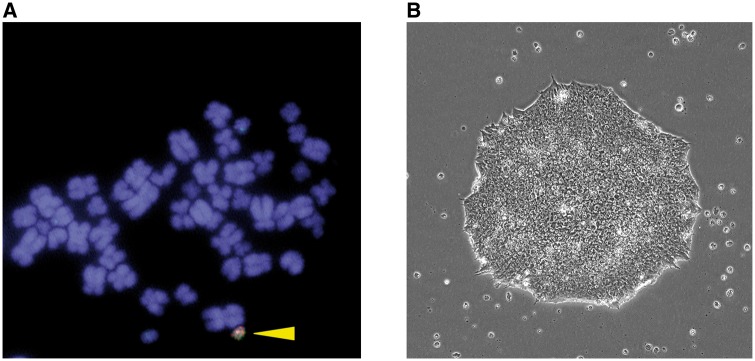
 Human iPSCs after microcell-mediated chromosome transfer of human artificial chromosome. (A) FISH analysis. The HAC is labeled green (alphoid probe) and red (BAC probe) and is indicated by a yellow triangle. An arrowhead shows the HAC. (B) Phase-contrast image.